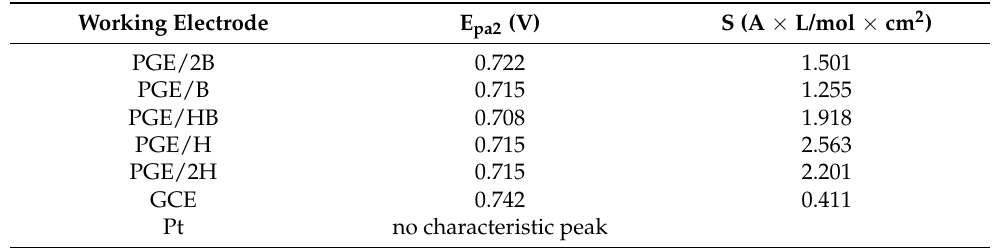
Figure 2. Differential pulse voltammograms recorded at different working electrodes for 4.00 × 10 − 6 mol/L HESP in BRB solution pH 1.81. Table 1. Peak potentials (E pa2 ) and sensitivities (S) of 4.00 × 10 − 6 mol/L HESP main oxidation signal (a2) obtained in BRB solution pH 1.81 by DPV at various working electrodes.